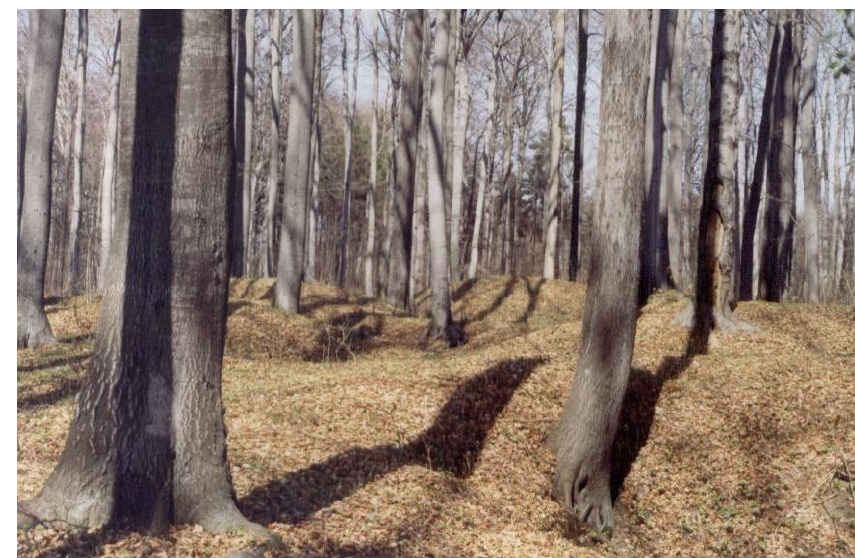
Fig. 2. Abandoned workings and subsidence in the natural reserve “Segiet” in Bytom ( M. Lamparska